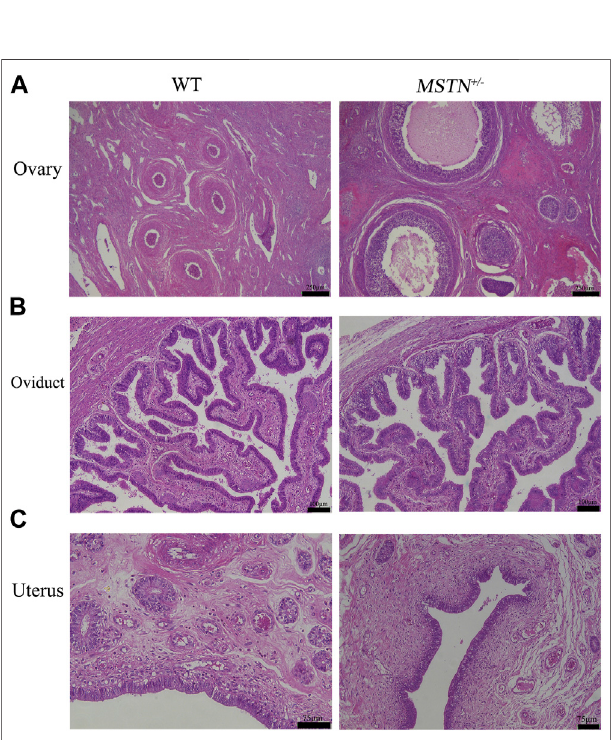
Frontiers in Genetics |